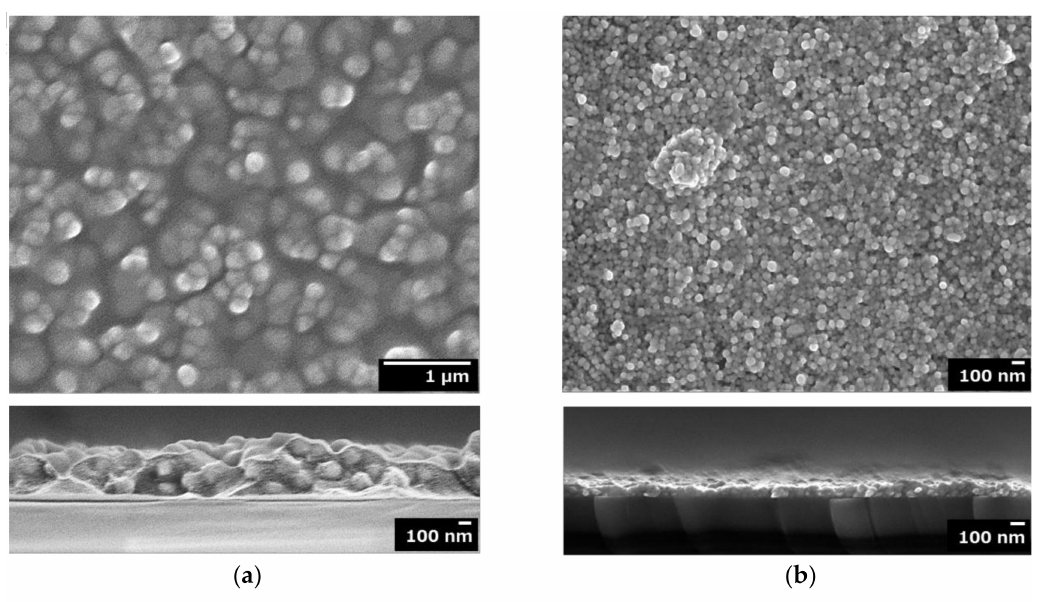
Figure 3. Field emission scanning electron microscopy (FE-SEM) images showing the top and cross-section views of the F” edta ( a ) and F” mix ( b ) films on quartz glass